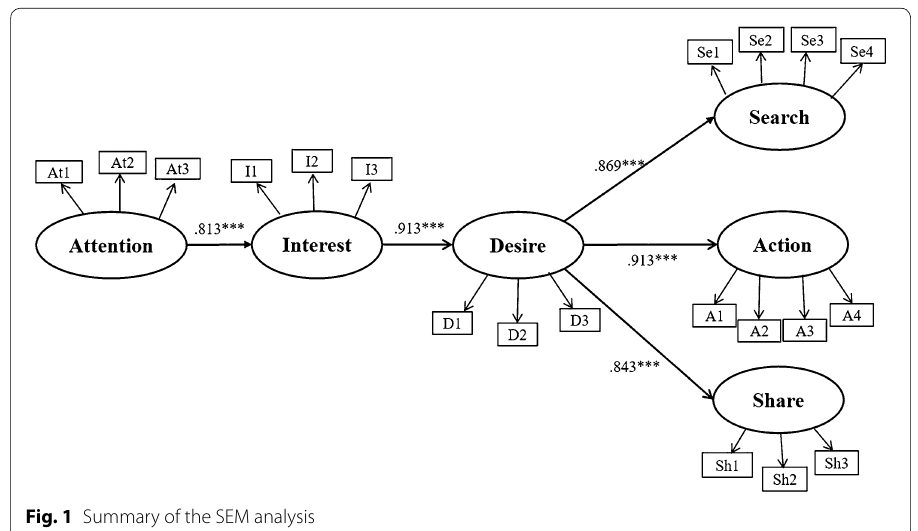
Fig. 1 Summary of the SEM